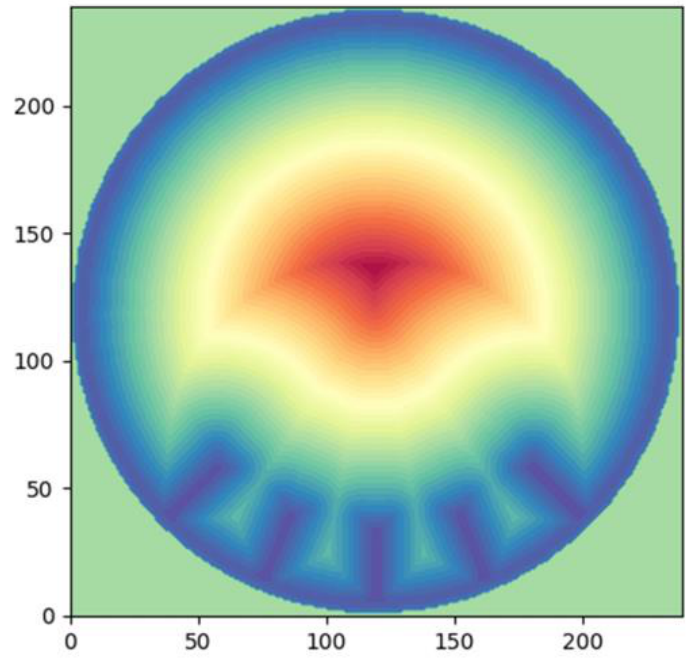
Figure 4. Absorber tube geometry presented by